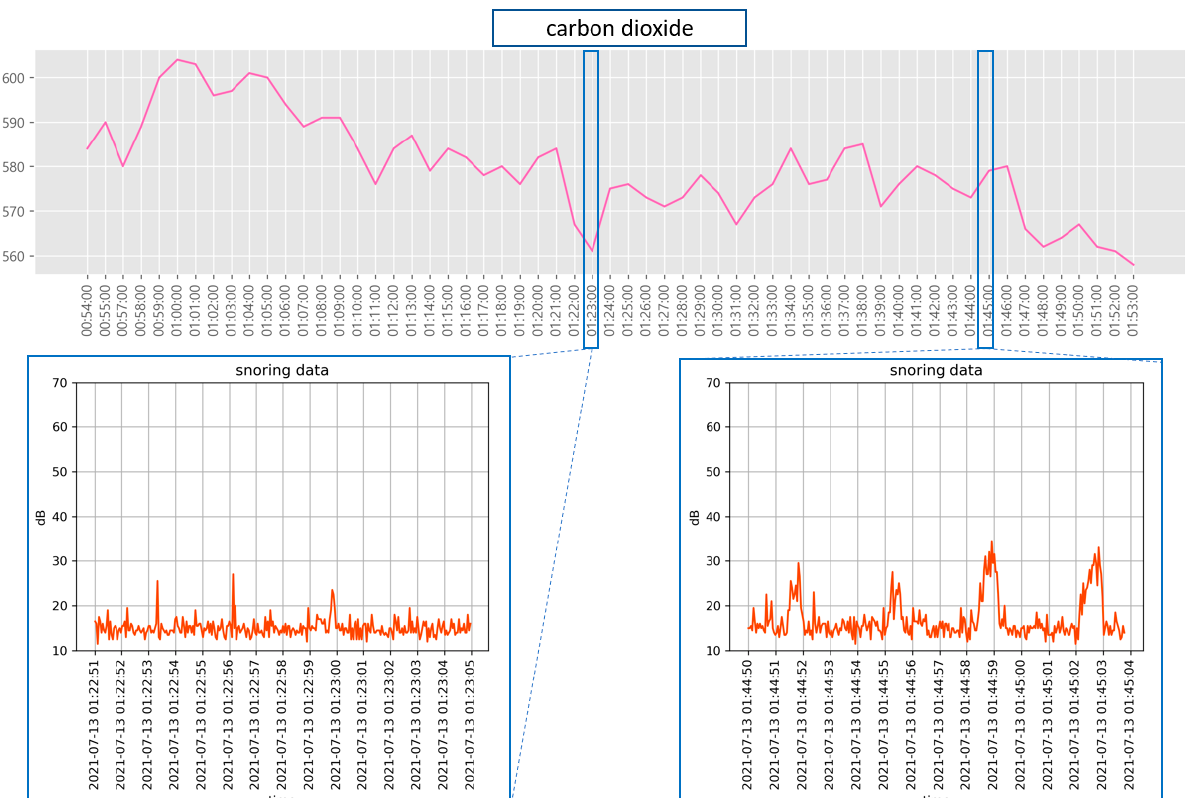
Figure 16. Comparison of snoring sound and heart rate.